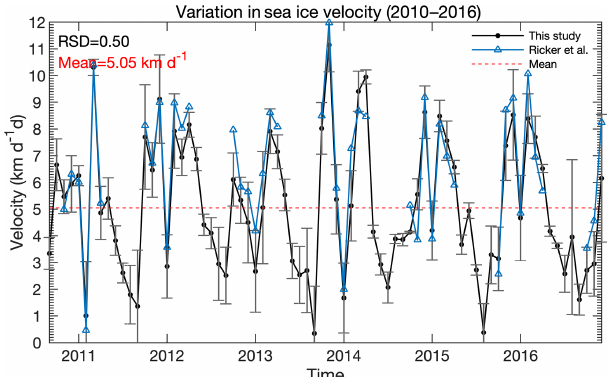
Figure 7. CMST sea ice drift averaged over the entire Fram Strait gate, from September 2010 to December 2016. The black dotted line represents monthly mean ice drift based on CMST data with corresponding standard deviations while the blue dotted line shows the monthly mean ice drift of OSI SAF.